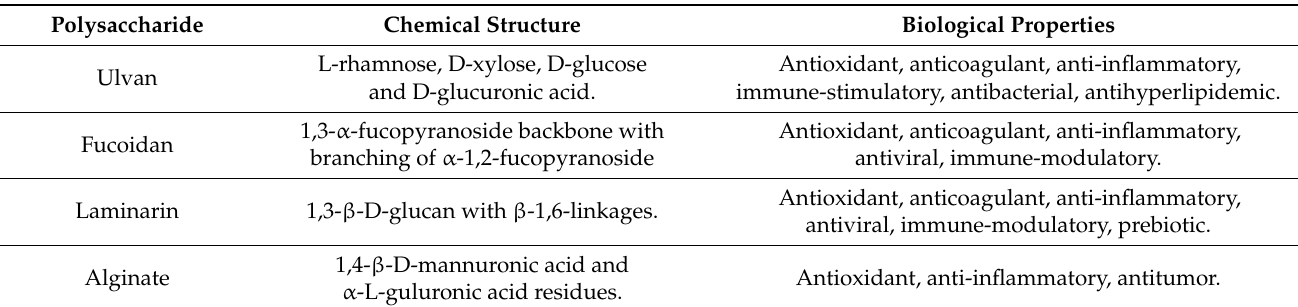
Table 1. Main polysaccharides of interest in